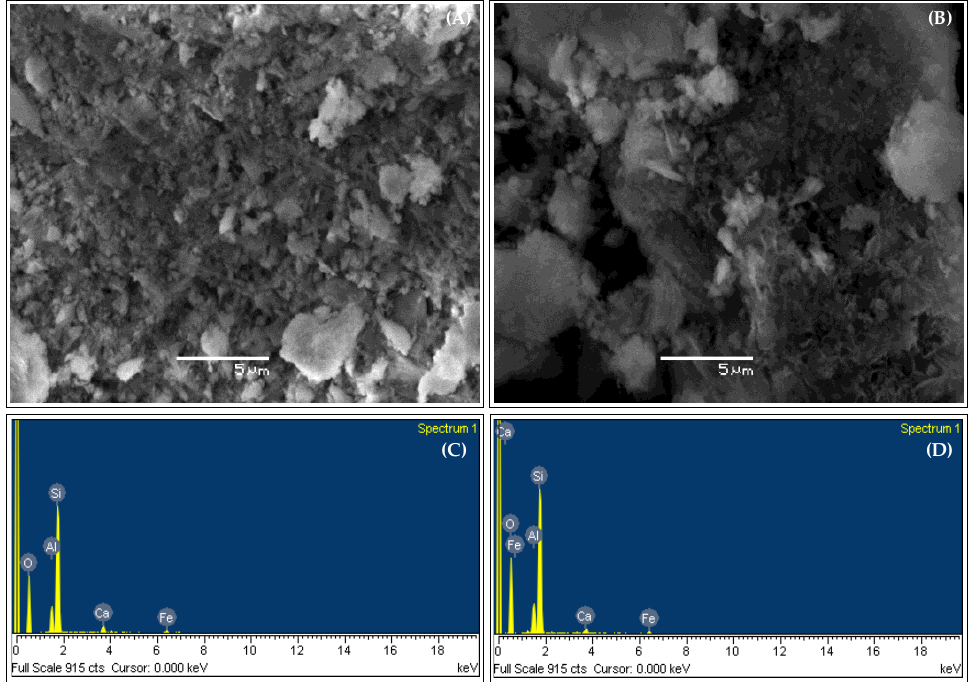
Figure 6. SEM-EDS results. ( A , C ) natural zeolite; ( B , D ) acidic transformed natural zeolite.